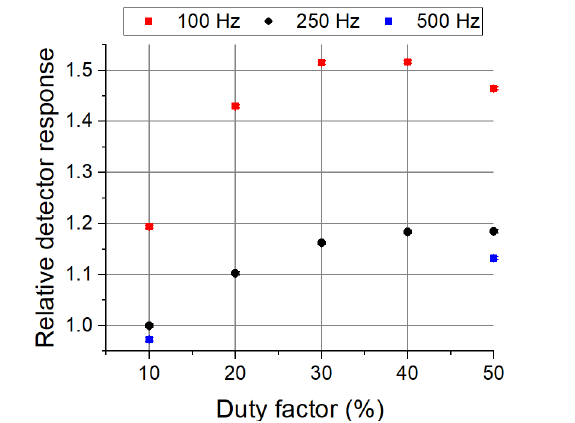
Fig. 9 Cadmium-covered detector response to P-385 D-D neutron generator operated in pulsed mode demonstrating the neutron output dependence on pulsing frequency and duty factor at constant high-voltage and beam current.